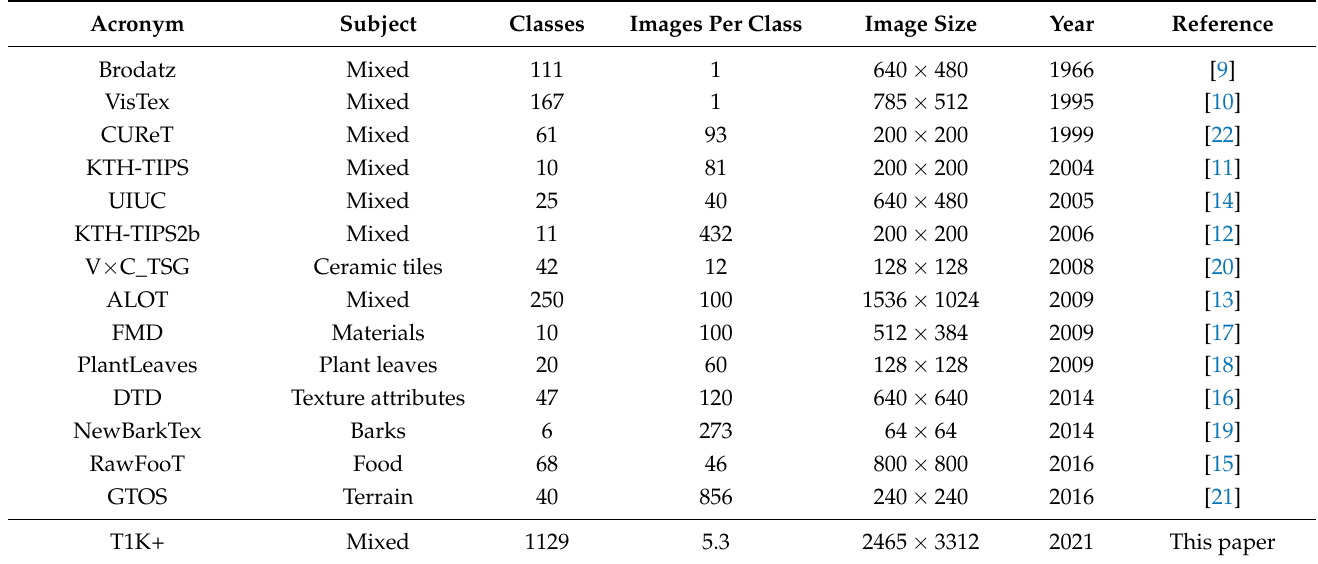
Table 1. Summary of a selection of texture databases in the literature. All the databases except Brodatz contain color images.